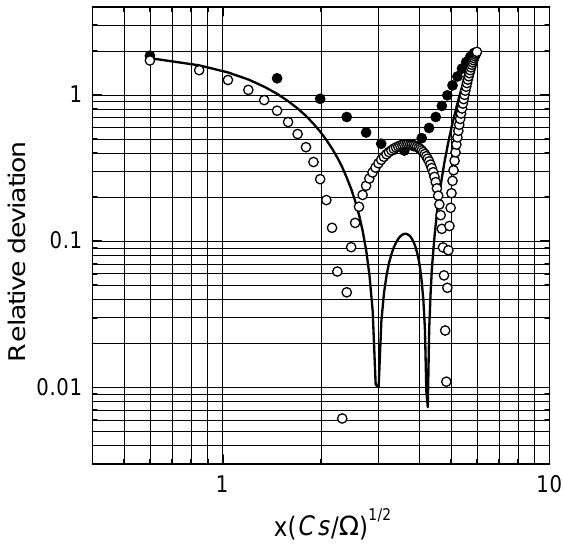
FIG. 9. Same as in Fig. 8, but (cid:120) (cid:173) (cid:51) . Solid line: (cid:116) (cid:48) (cid:173) (cid:51) ; solid circles: (cid:116) (cid:48) (cid:173) (cid:50) ; open circles: (cid:116) (cid:48) (cid:173) (cid:52) .